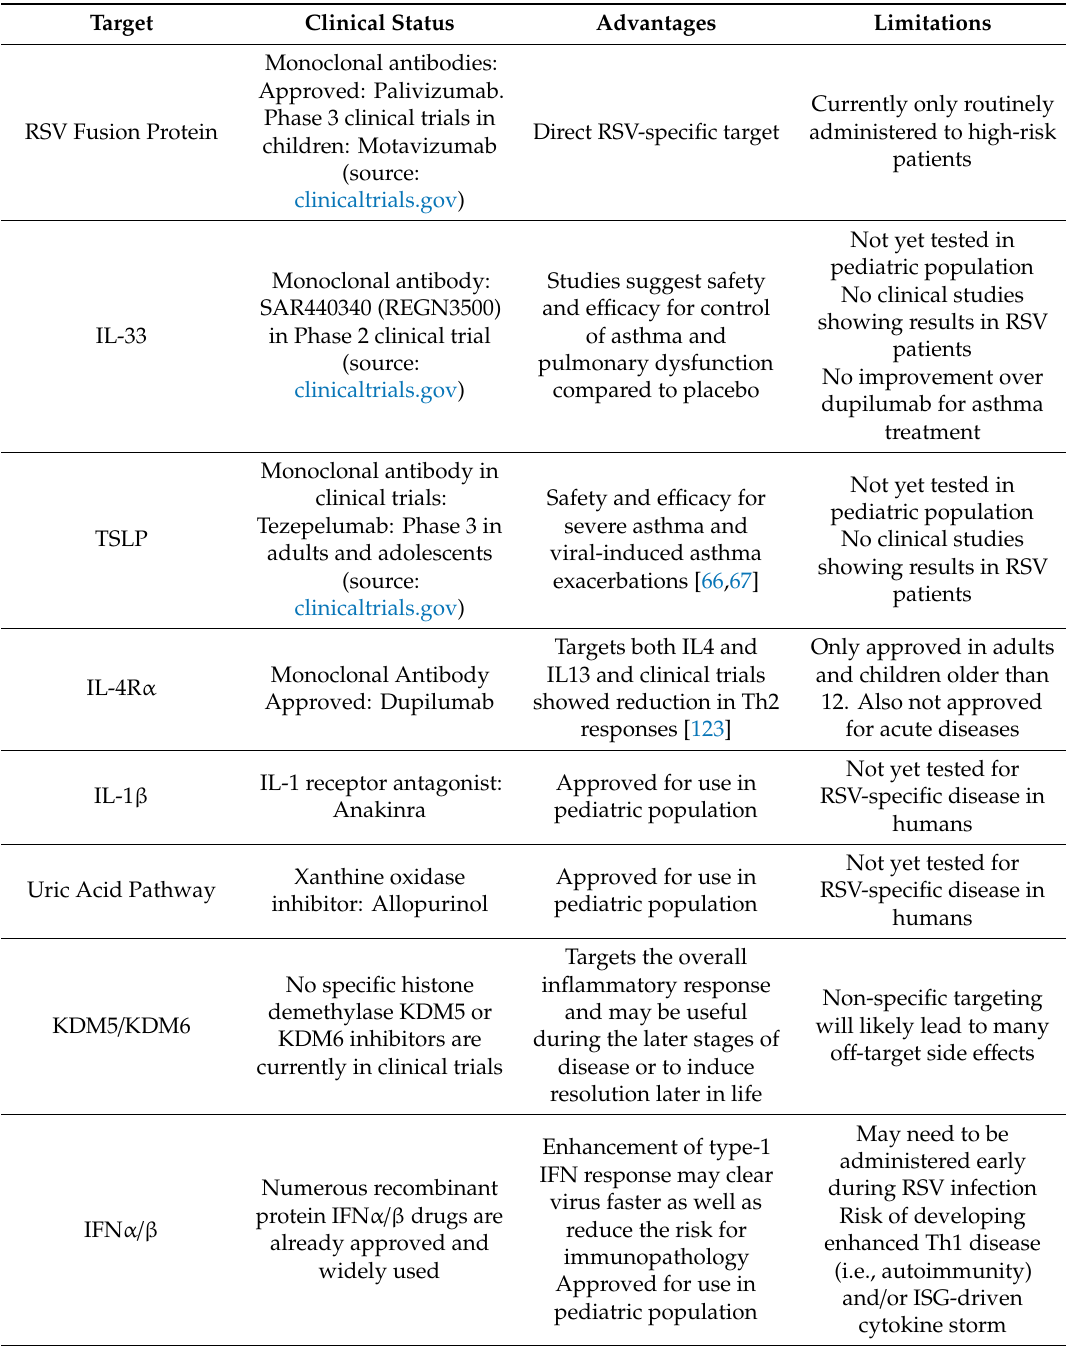
Table 1. Overview of Current and Predicted RSV Therapeutic